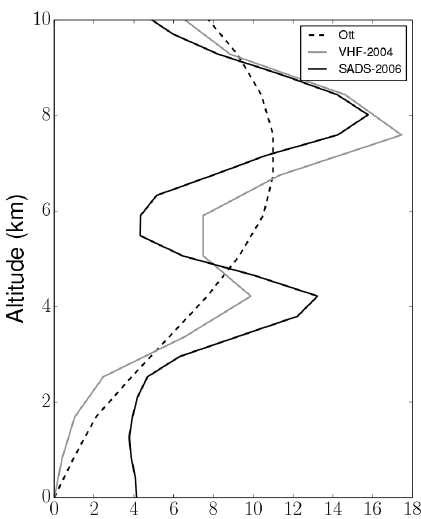
Figure 7. Vertical lightning emission profiles. The Ott LNO x ver- tical emission profile is used by GEOS-Chem in the subtropical re- gions (Ott et al., 2010). The VHF-2004 and SADS-2006 LNO x ver- tical emission profiles are alternative LNO x emission profiles and were used in the study by Allen et al. (2012). The horizontal axis represents the fractional percentage of LNO x